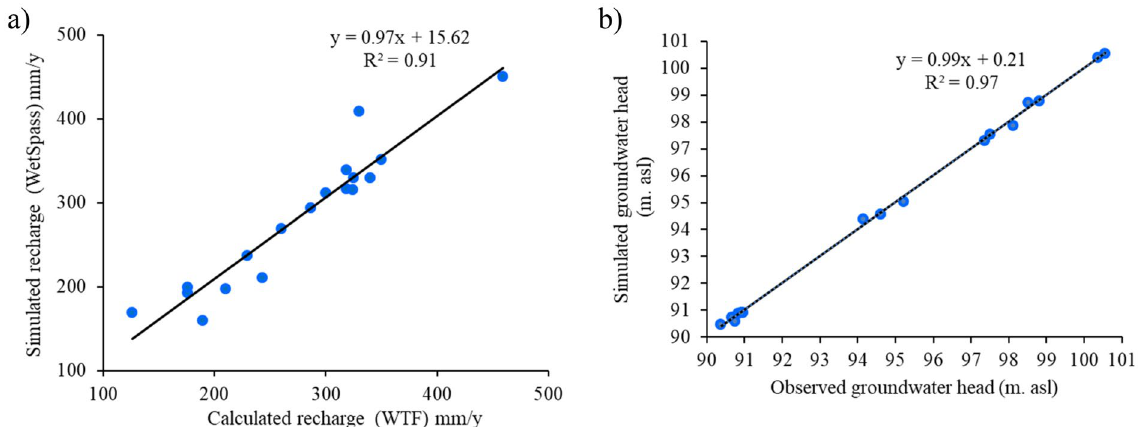
Figure 5. Scatter plot: ( a ) between the simulated recharge values (WetSpass-M) and calculated values (WTF) of groundwater recharge for 18 monitoring points; and ( b ) between simulated groundwater head and observed heads of 18 observation